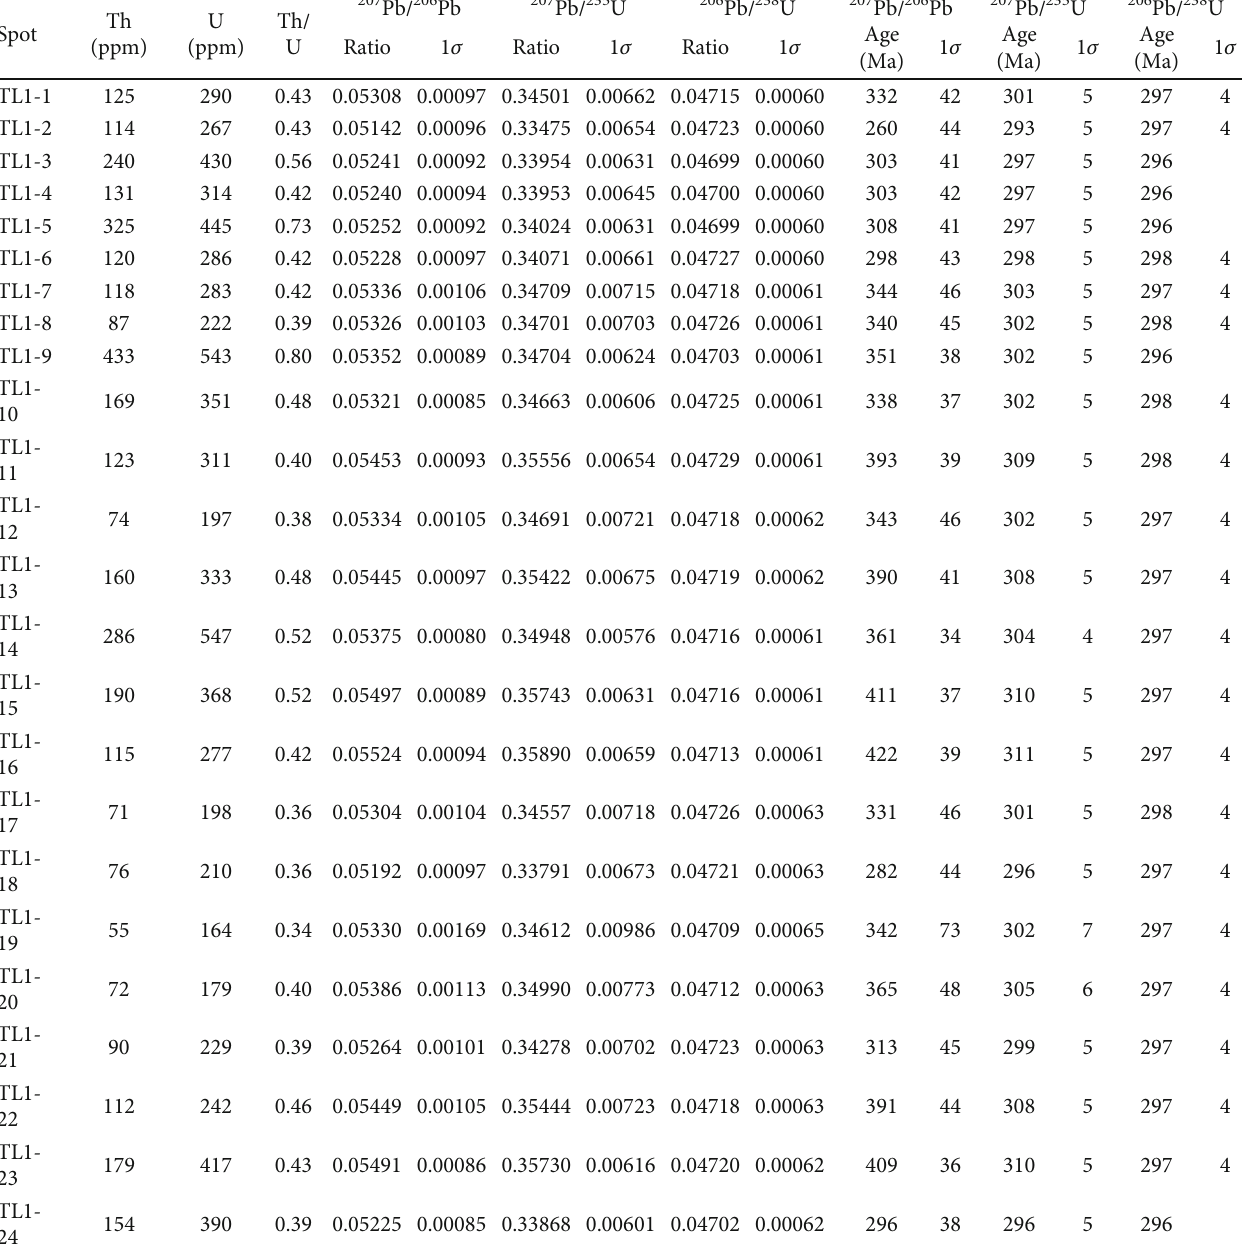
Table 1: LA-ICP-MS U-Pb data of zircon grains from granite porphyry of the Tieling